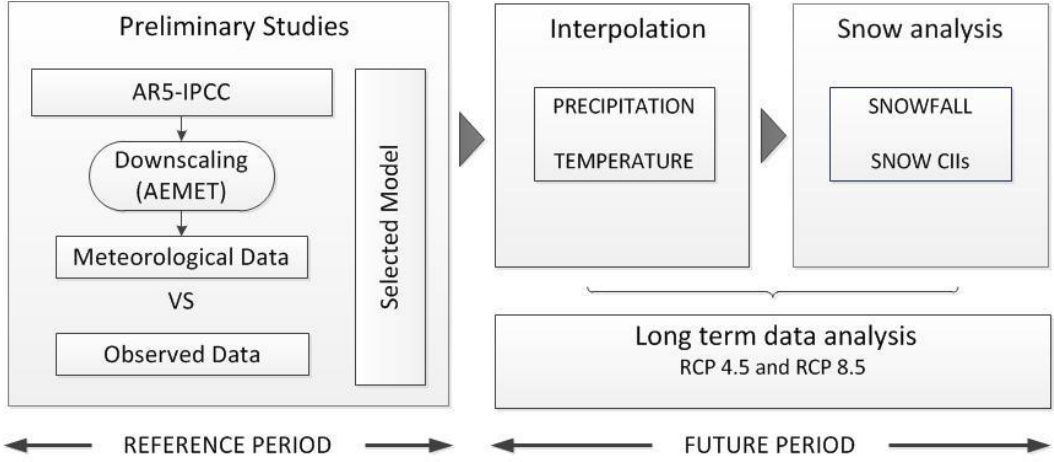
Figure 2. The overall research design and work flow chart for this study. AEMET is the Spanish Meteorological Agency, which is the data source of the historical and projected climate variables for future scenarios RCPs4.5 and 8.5 in the Fifth Assessment Report of the Intergovernmental Panel for Climate Change (AR5 IPCC)) [14]. CIIs are the climate impact indicators defined for torrentiality assessment.